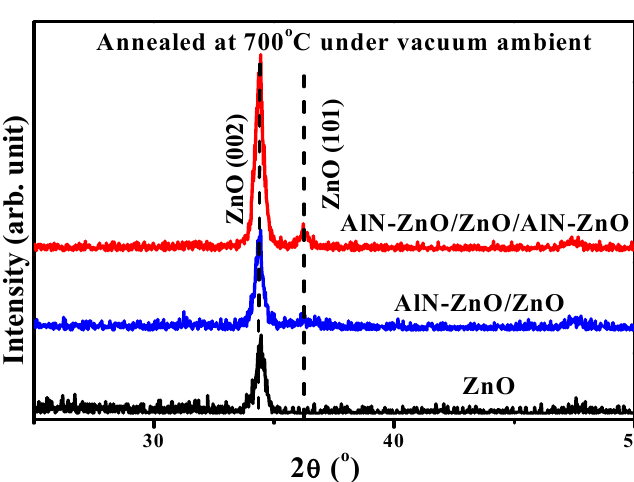
Figure 6. XRD patterns of the undoped ZnO film deposited onto the substrate with and without an AlN-ZnO buffer layer, as well as the undoped ZnO film sandwiched in the cosputtered AlN-ZnO films, after annealing at 700 °C under vacuum ambient for 30 min.